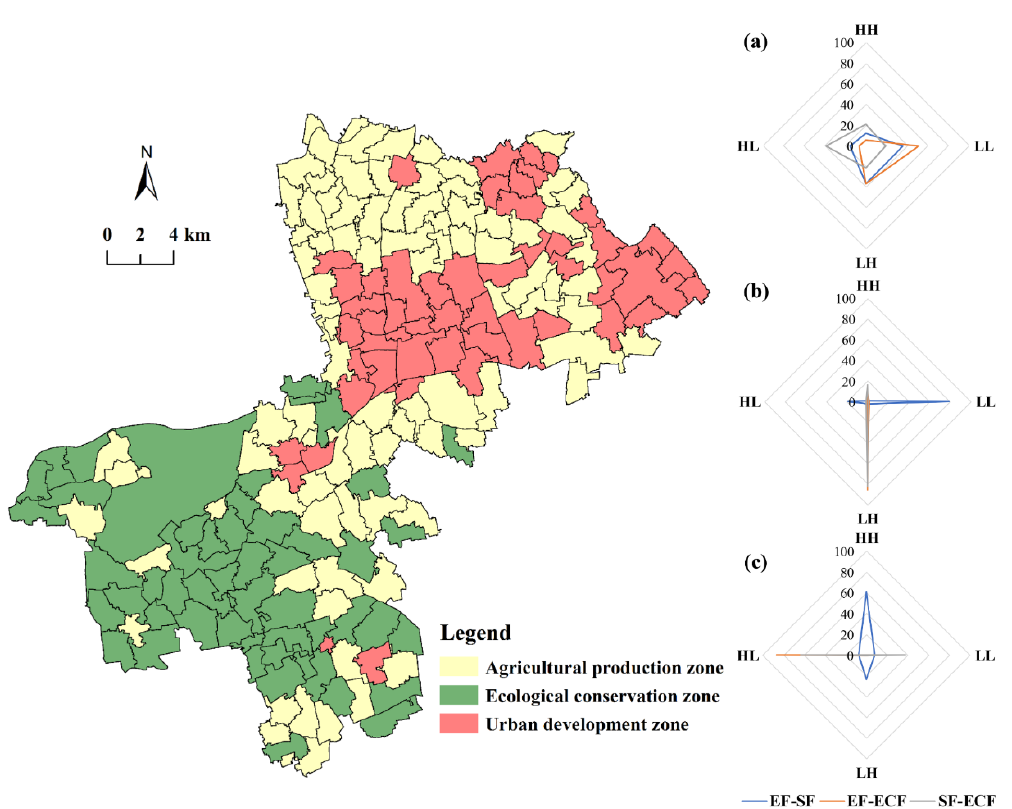
Figure 8. Land use function zoning in Qingpu District. Panels ( a – c ) show the proportion of each kind of trade ‐ off and synergy of agricultural production zone, ecological conservation zone, and urban development zone, respectively (EF—economic function; SF—social function; ECF— ecological